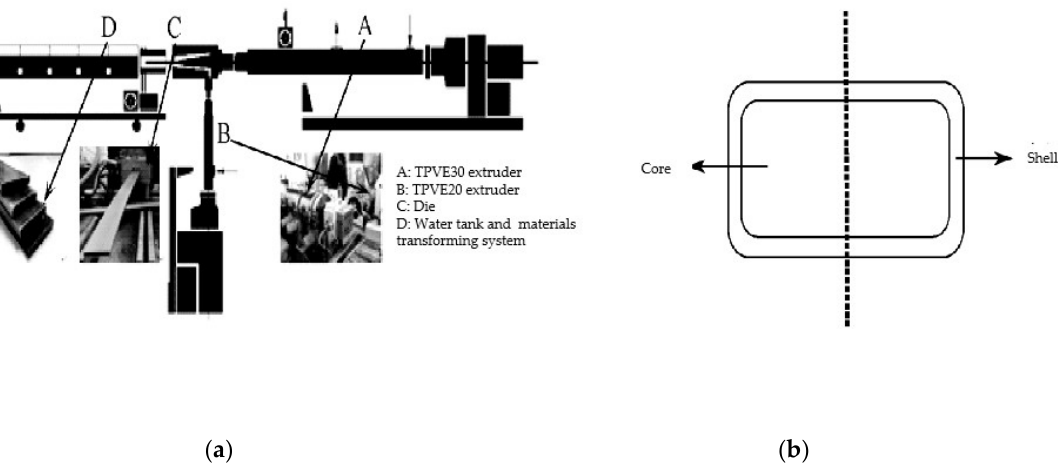
Figure 1. Preparation diagram of core–shell structured WPCs. ( a ) Preparation; ( b ) Cross section diagram .